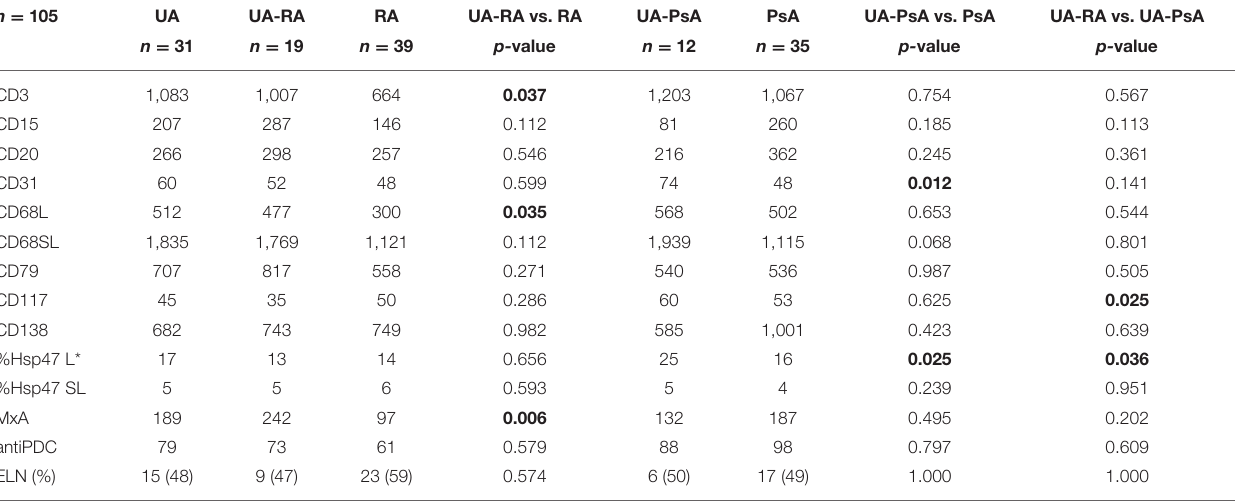
Mean comparison. * Data shows cells number/mm 2 and percentage. UA, undifferentiated arthritis; RA, rheumatoid arthritis; PsA, psoriatic arthritis; UA-RA, UA evolving to RA; UA-PsA, UA evolving to PsA; L, lining; SL, sublining; HsP47, heat shock protein 47; MxA, antiviral response protein MxA; PDC, plasmocytoid dendritic cell; ELN, Ectopic lymphoid neogenesis. p-value in bold remarks statistical significance.